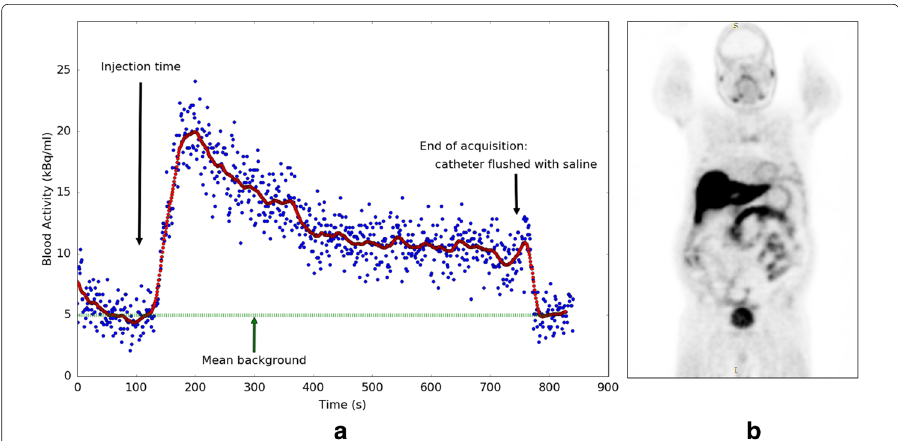
Fig. 13 a Time-activity curve not corrected for dispersion, where the injection time corresponds to the beginning of the acquisition time corrected by 125 s. The dispersion is relatively large due to the long catheter used in this proof of concept study. b Dynamic PET image of the patient with attenuation